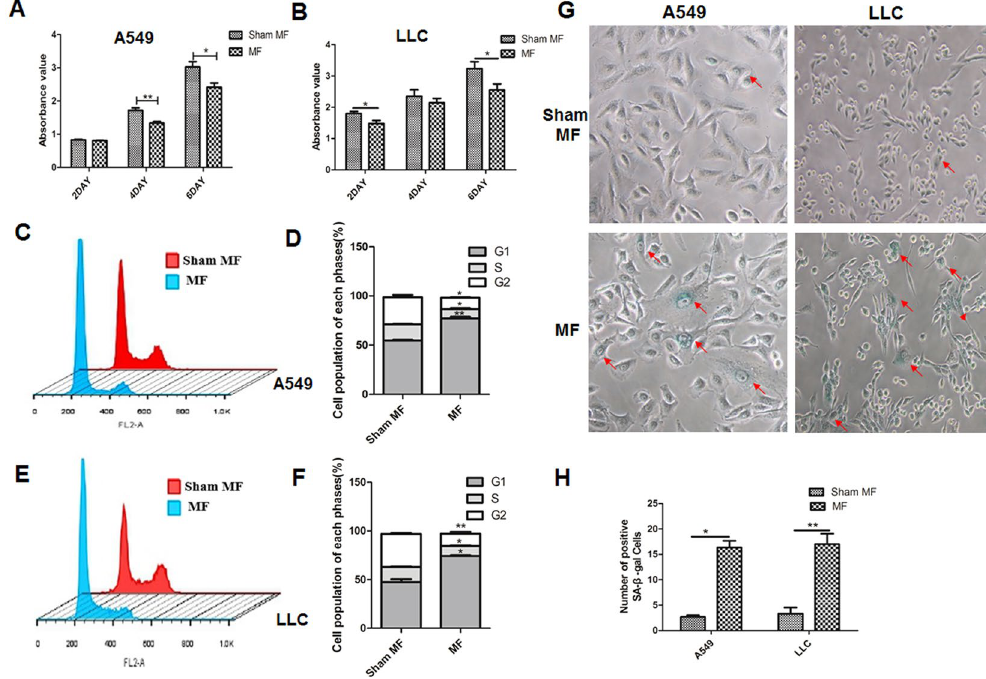
Figure 2. Low frequency magnetic fields induce cell proliferation inhibition, cell cycle arrest and cell senescence of lung cancer. A549 cells and LLC cells were exposed to LF-MF (0.4T, 7.5 Hz) or Sham MF for 6 days (2 h per day). ( A , B ) Cell proliferation rate was detected using CCK-8 assay after exposure to MF. (C , D ) Cell cycle of A549 cells was detected by using flow cytometry after exposure to MF for 6 days. Mean percentage of G1, S and G2 phase cells was calculated. ( E , F ) Cell cycle of LLC cells was detected by using flow cytometry after exposure to MF for 6 days. Mean percentage of G1, S and G2 phase cells was calculated. ( G ) Cells was subjected to SA- β -gal staining after exposure to MF for 6 days. ( H ) Numbers of SA- β -Gal positive cells was calculated. All experiments were repeated three times. Data represent Mean ± SEM. * P < 0.05, ** P < 0.01 and *** P <